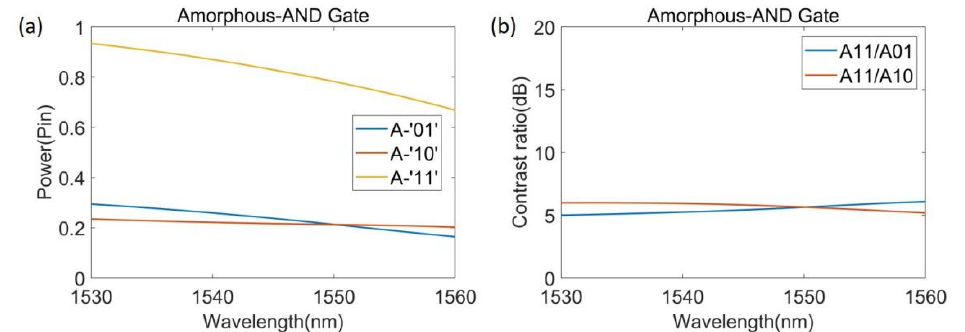
Figure 6. Performance graph of AND gate. ( a ) Spectral power curve of the AND gate when Sb 2 Se 3 is in the amorphous state; ( b ) Contrast ratio curve of the AND gate.